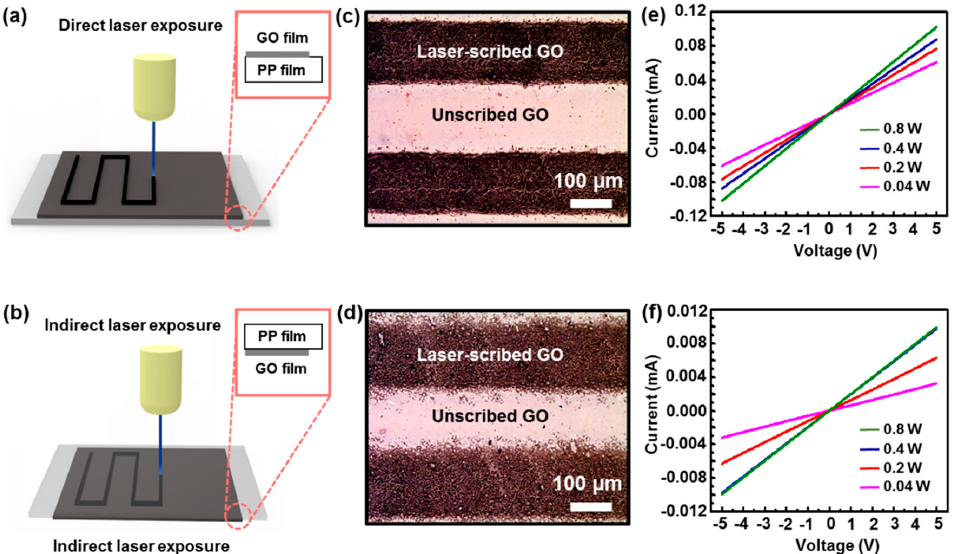
Figure 3. Laser-scribed patterning and reduction of GO thin films formed on PP substrate to fabricate rGO-GO-rGO stripes with a controlled mode of operation. ( a ) Direct laser exposure on GO-PP substrate. ( b ) Indirect laser exposure on GO film through PP barrier. The inset drawings in figure ( a , b ) illustrates the surface position of GO film and PP substrate against the laser exposure. ( c , d ) Optical micrographs showing the patterned rGO-GO-rGO stripes operated by direct and indirect laser exposure (dark lines: laser-scribed rGO, bright line: unscribed pristine GO). ( e , f ) Typical I-V characteristics of the samples scribed by direct and indirect laser operations.